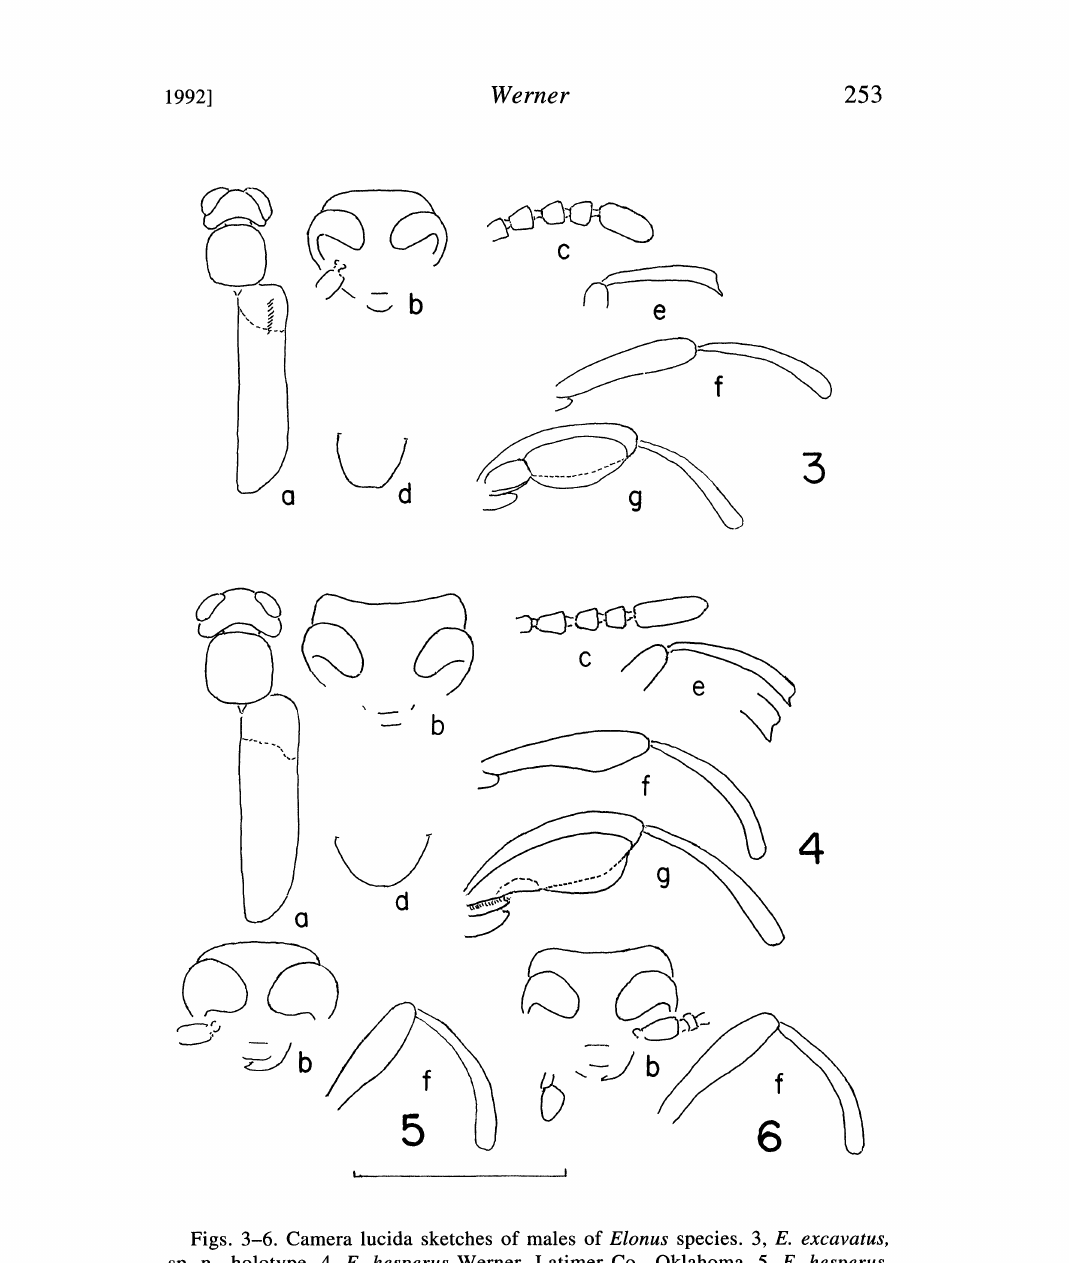
Figs. 3-6. Camera lucida sketches of males of Elonus species. 3, E. excavatus, sp. n., holotype. 4, E. hesperus Werner, Latimer Co., Oklahoma. 5, E. hesperus, Santa Engracia, Tamaulipas, Mexico. 6, E. hesperus, Molino Basin, Sta. Catalina Mts., Arizona. Explanation of letters and scale as on Figs.